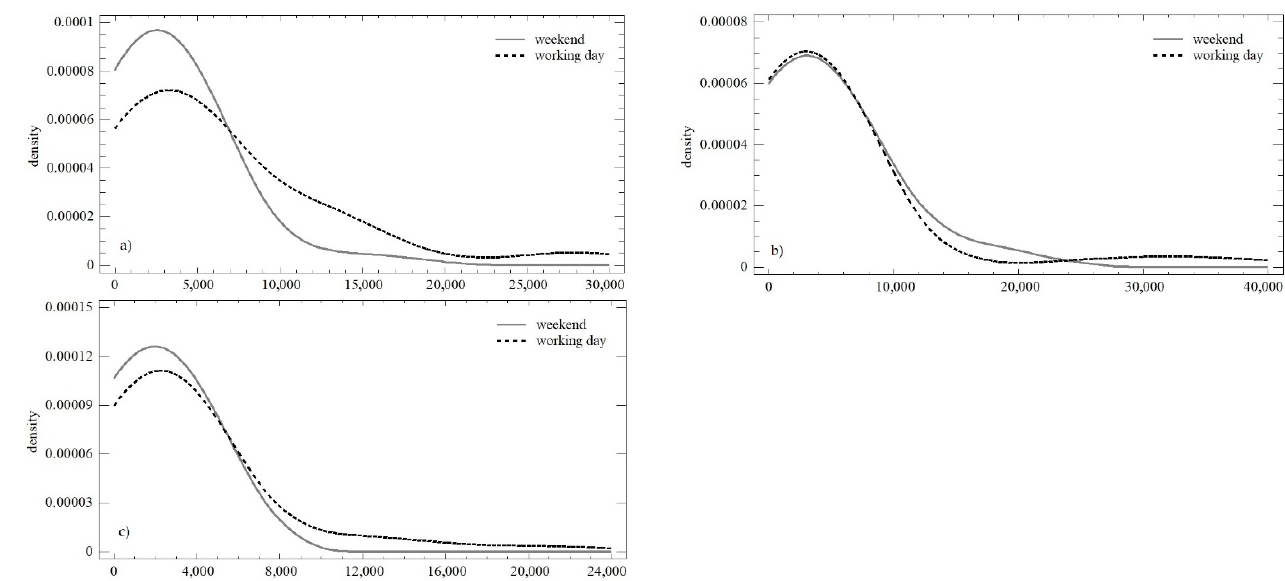
10 of 20 Table 4. Linear regression model for likes during working days and weekends in each observation. Regression Models working days